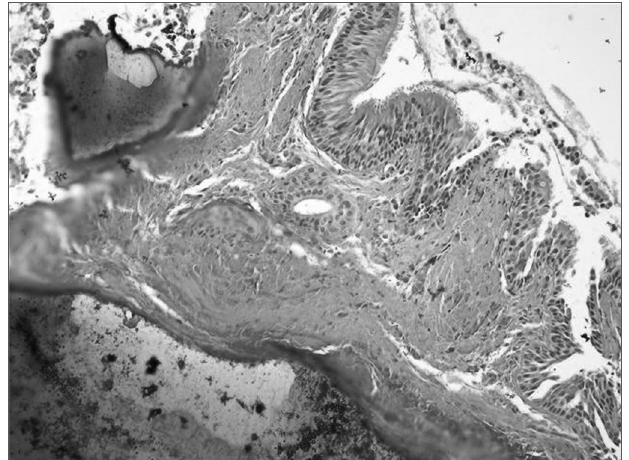
Figura 3. Lâmina histológica: placas de ossificação no córion da mucosa respiratória.